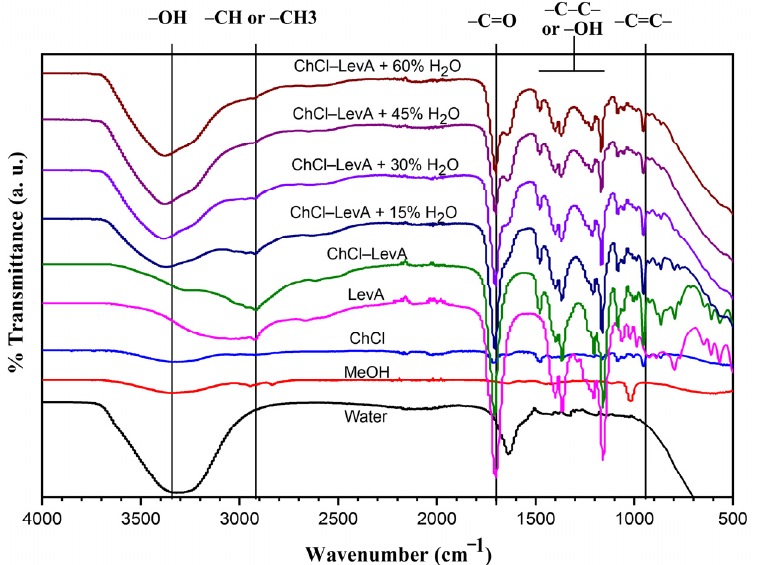
Figure 2. FT-IR spectra of water, MeOH, ChCl, LevA, ChCl-LevA (1:2) and ChCl-LevA with different addition amounts of water in solvent (15, 30, 45, and 60% w / w ).